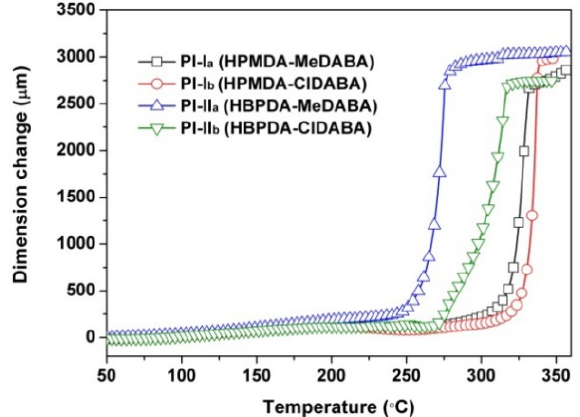
Figure 13. TMA curves of PI films.